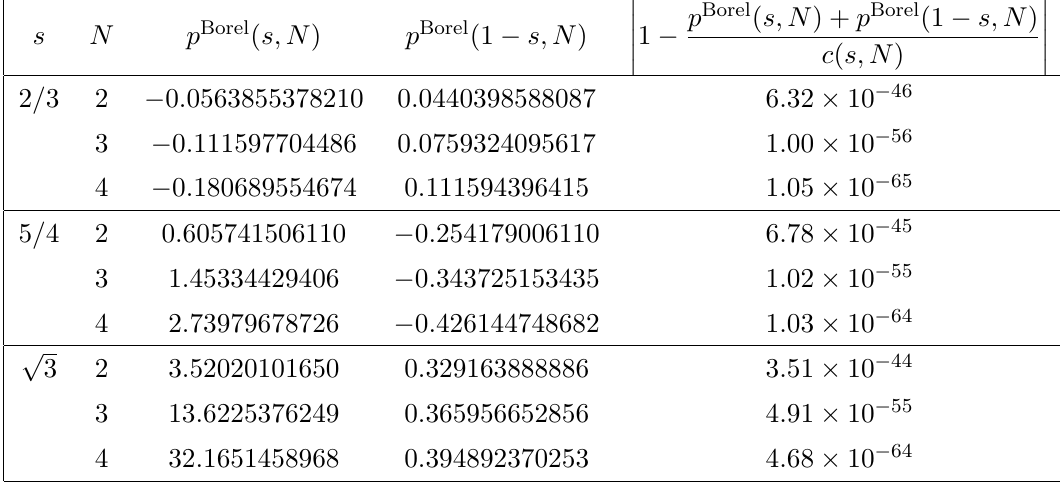
Table 1. The Borel-Padé resummation of the asymptotic 1 /N expansion (3.4). The individual resummation p Borel ( s, N ) or p Borel (1 − s, N ) does not reproduce the exact result of c ( s, N ) . The sum of them does. We used f g ( s ) up to g = 120 and the diagonal Padé approximant of the Borel transform. The numerical values of the large N resummation show a remarkable agreement even for N = 2 . We also set a = 1 in the numerical